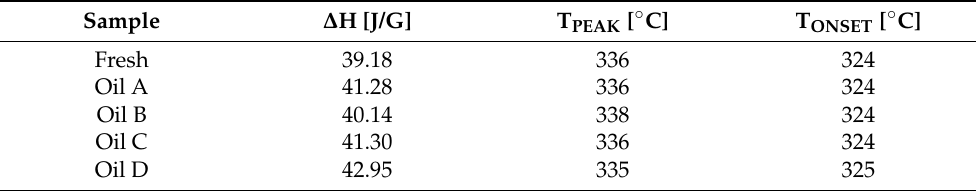
Table 6. DSC results for the PTFE samples (fresh and aged in the ATFs). Sample